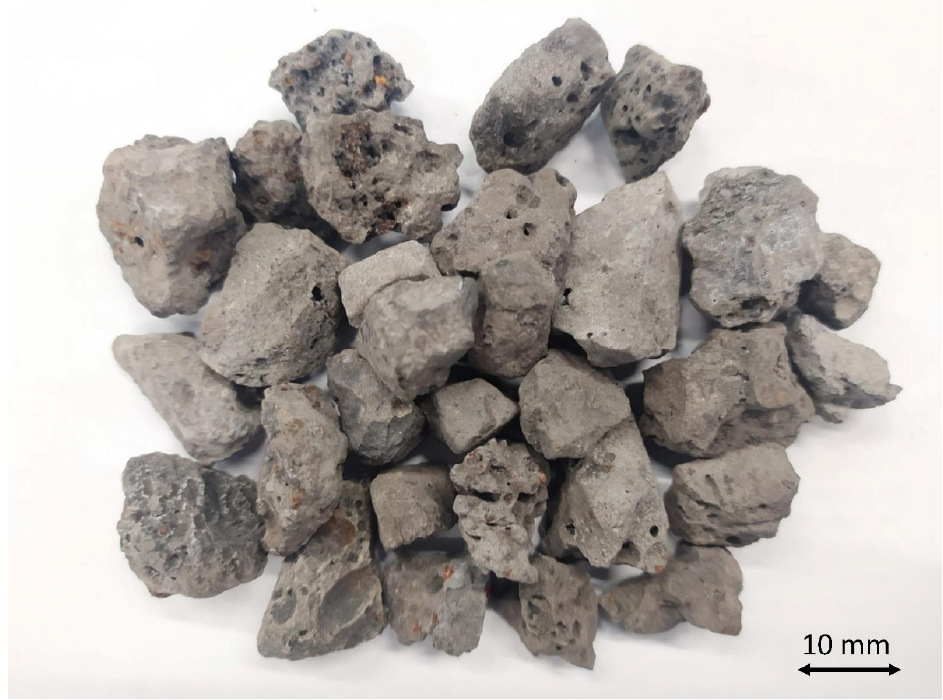
Figure 3. Image of electric arc furnace slags.